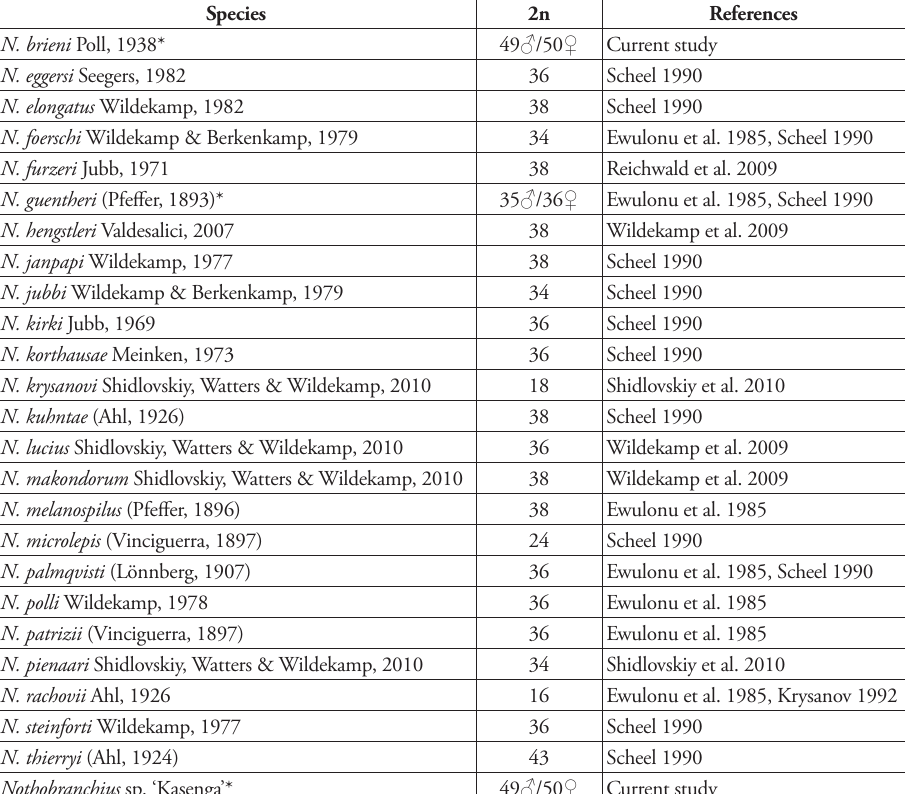
X Y/X X X X 1 2 1 1 2 2